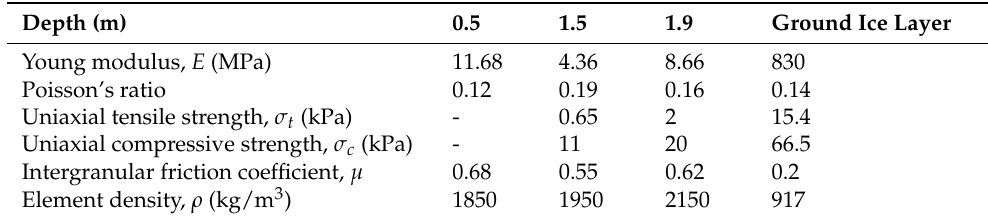
Table 1. Geotechnical properties at the K1129W thaw slump site.